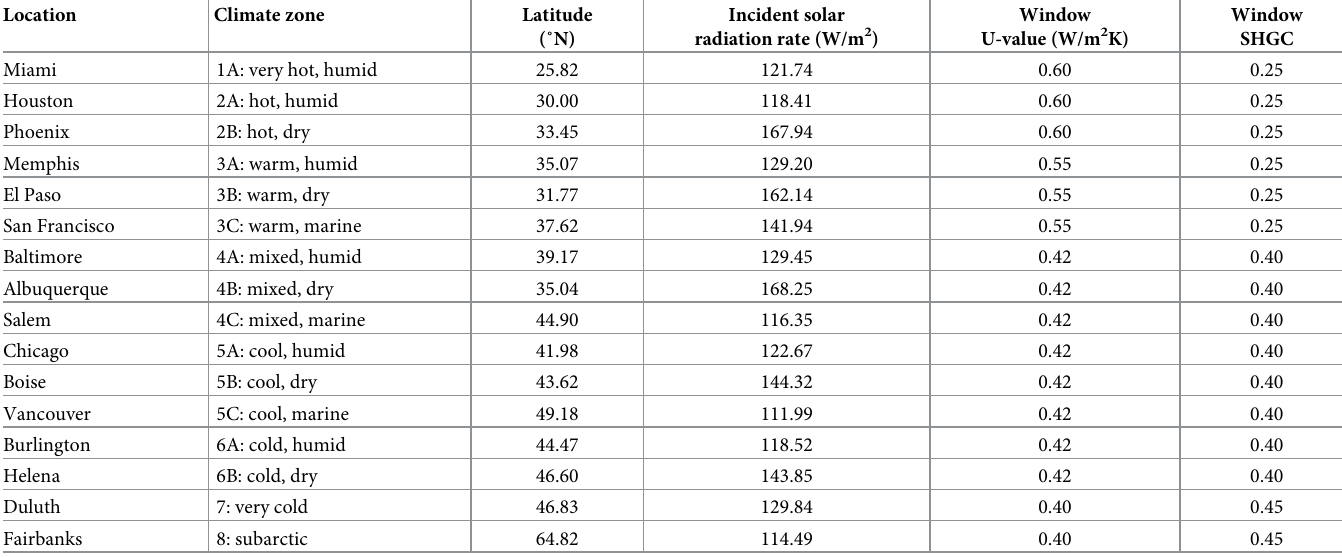
Table 1. Model locations and selected parameters.